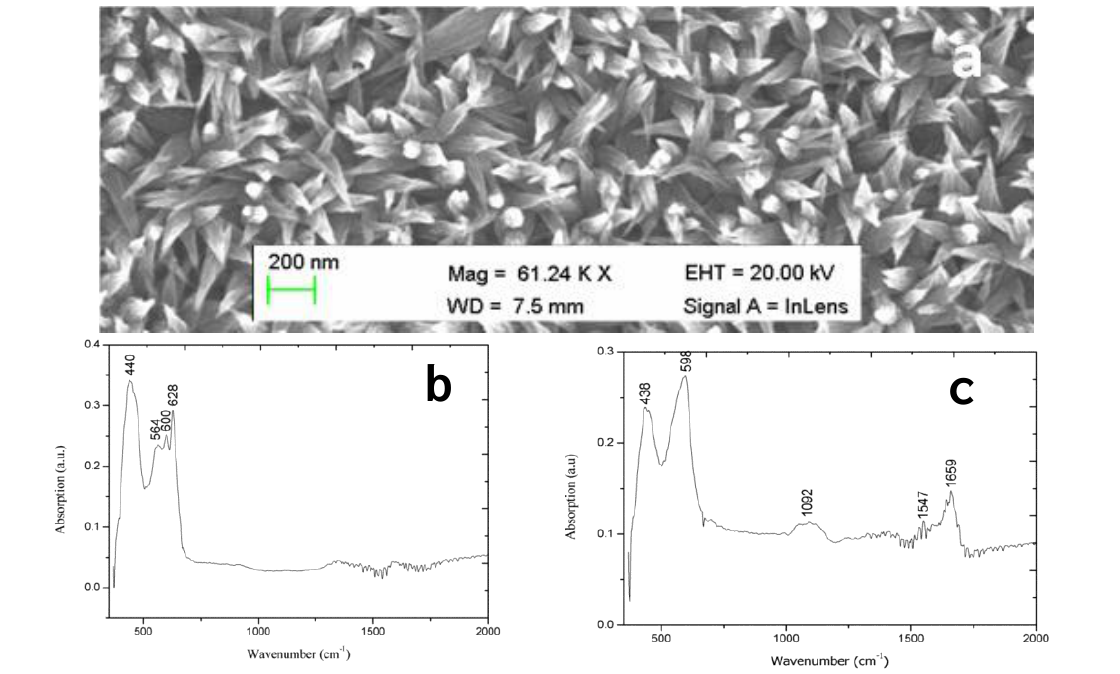
Figure 8. ( a ) SEM images of CuO nanoleaves; ( b ) IRAS spectrum of the pure CuO nanoleaves; and ( c ) IRAS Spectrum of CuO nanoleaves with immobilized glucose oxidase